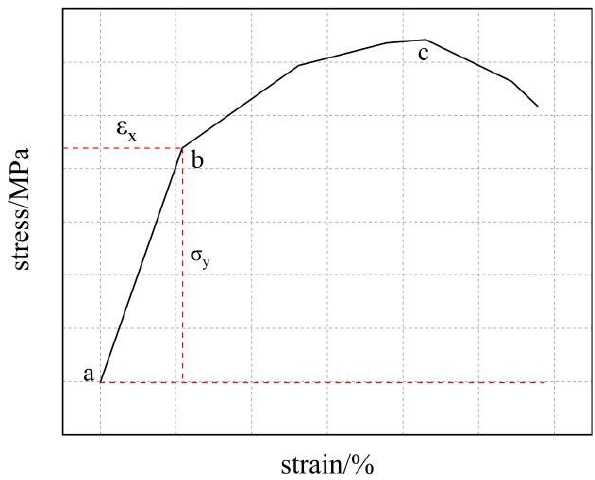
Figure 4: Schematic diagram of stress-strain